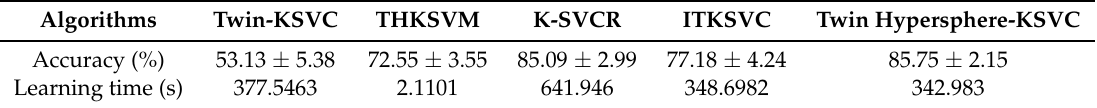
Classification results of Twin Hypersphere-KSVC, Twin-KSVC, THKSVM, K-SVCR and ITKSVC for handwritten digits recognition on the USPS dataset.